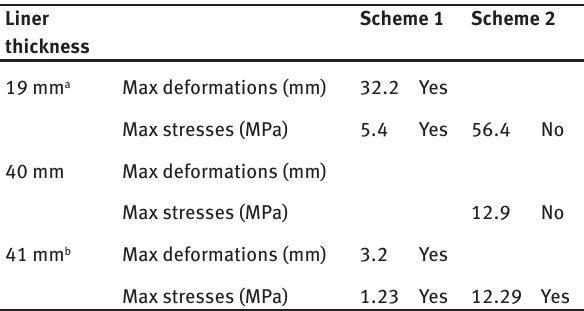
Table 1: Thicknesses of the sleeve calculated for the assumed load